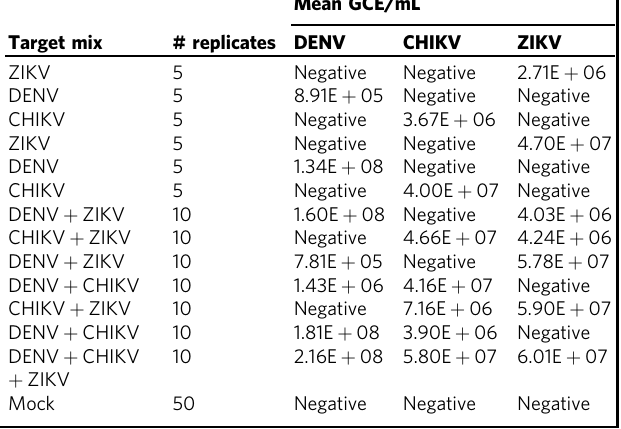
detection is critical for every diagnostic assay, especially when the assay is intended to accurately discriminate between diseases caused by similar pathogens or similar clinical presentations. To evaluate the speci fi city of the Trioplex real-time RT-PCR assay, a panel was generated that contained different combinations of ZIKV, DENV or CHIKV suspended in a pool of human serum (Fig. 4b). The bene fi t of large volume RNA extractions on samples obtained from patients with febrile illness but had pre- increasing diagnostic sensitivities is even more evident when the viously tested negative by PCR for any of the virus targets tested CT value of each individual PCR reaction is compared between in this study. Multiple combinations of each target virus were extraction methods. The CT values of each individual multiplex mixed at concentrations ranging from 10 5 to 10 8 GCE/mL, RNA was extracted using the MagNA Pure LC 2.0 small volume or singleplex PCR reaction in the LoD dilution range obtained | DOI: 10.1038/s41467-018-03772-1 |